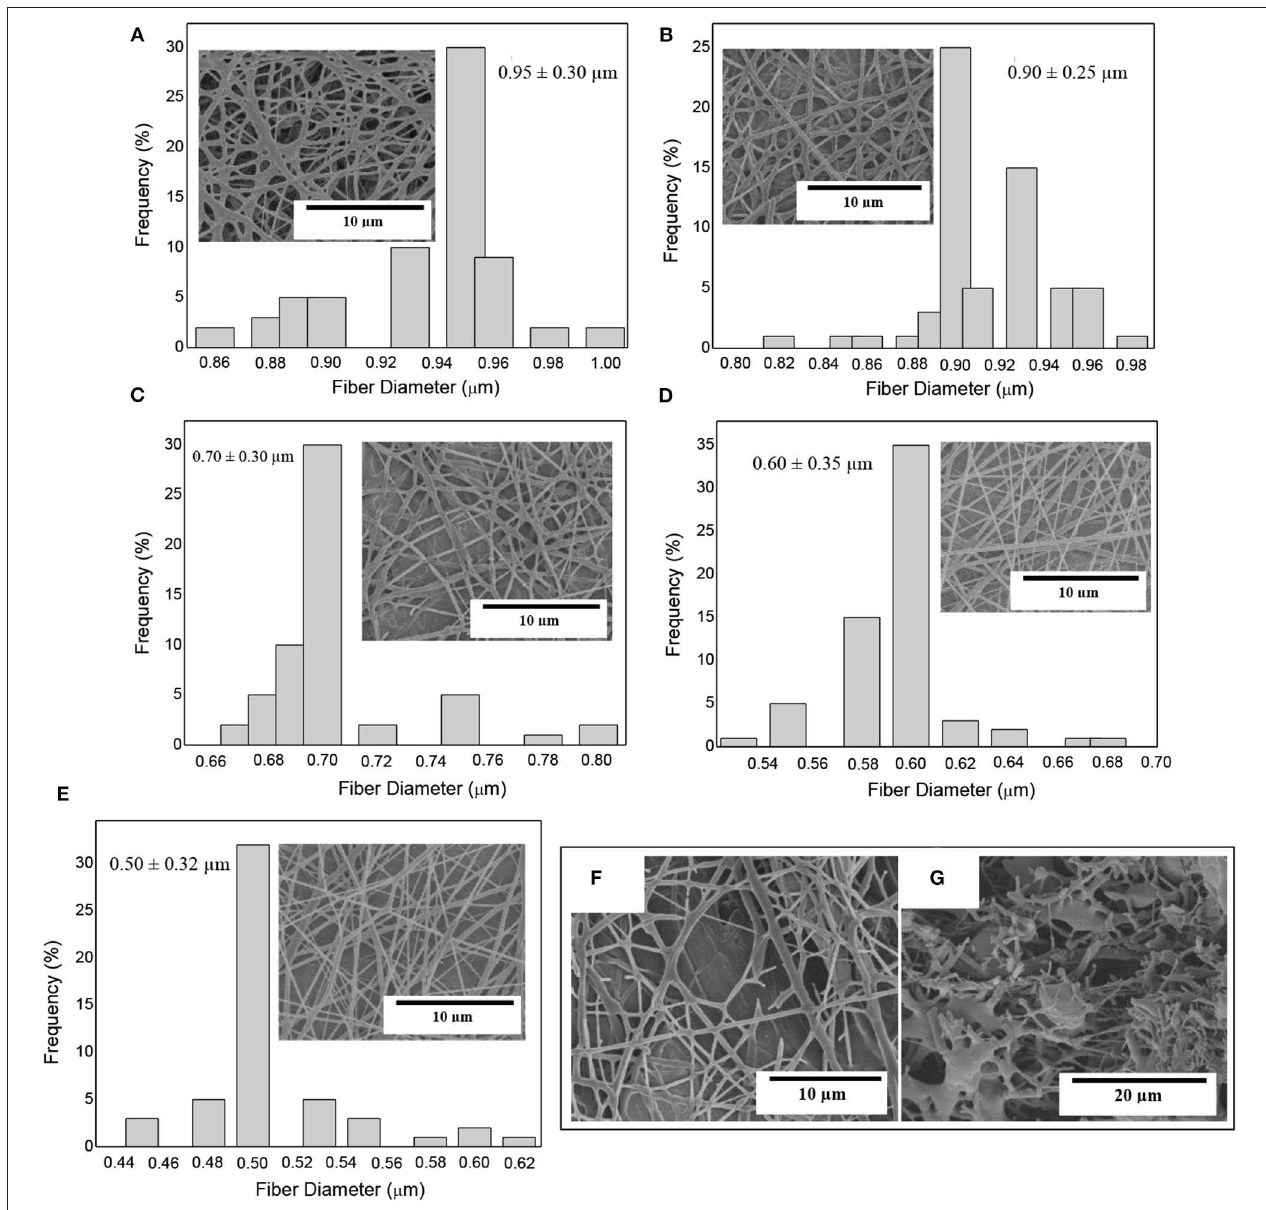
FIGURE 3 | Scanning electron microscopy (SEM) micrographs of electrospun fiber mats of poly(3-hydroxybutyrate- co -3-hydroxyvalerate) (PHBV) containing eugenol and their histograms: (A) Neat PHBV; (B) 2.5 wt.%; (C) 5 wt.%; (D) 10 wt.%; (E) 15 wt.%; (F) 20 wt.%; (G) 25